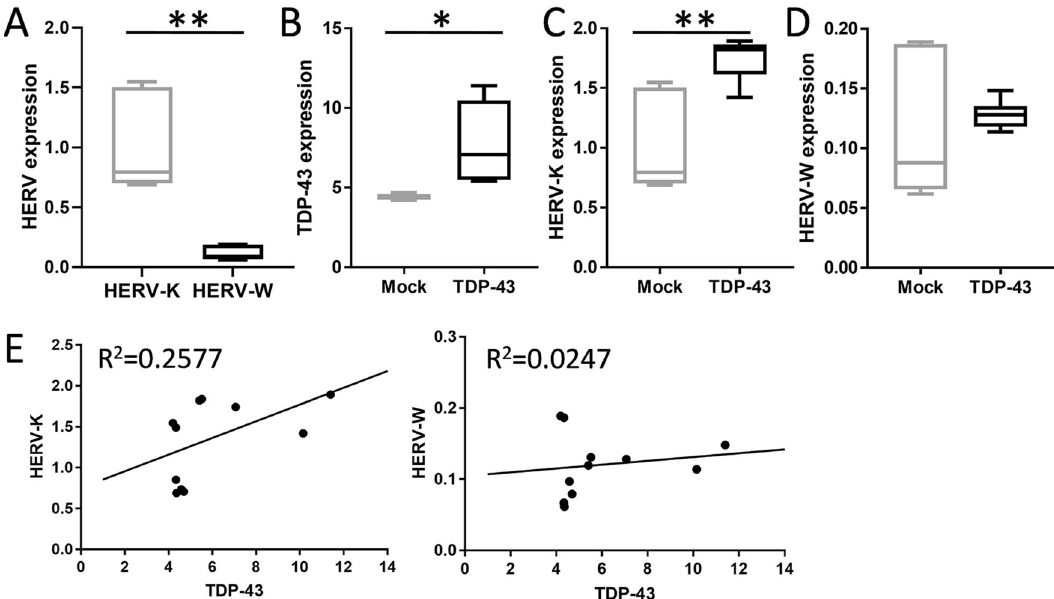
Fig. 4 TDP-43 induces HERV-K transcription. A HERV-K and HERV-W env levels in SH-SY5Y neuronal cells ( n = 6 biological replicates). B Expression of TDP-43 in SH-SY5Y neuronal cells transfected with the human wild type TARDBP cDNA (TDP-43) ( n = 5 biological replicates) or empty vector plasmid control (mock) ( n = 6 biological replicates). C Analysis of impact of TDP-43 on HERV-K env transcription in TDP-43 cells ( n = 5 biological replicates) and mock cells ( n = 6 biological replicates). D Analysis of impact of TDP-43 on HERV-W env transcription in TDP-43 cells ( n = 5 biological replicates) and mock cells ( n = 6 biological replicates). Boxplot data represent median with min and max as whiskers. * P < 0.05, ** P < 0.005. E Correlation analysis of TDP-43 to HERV-K and HERV-W env transcription ( n = 11 individual